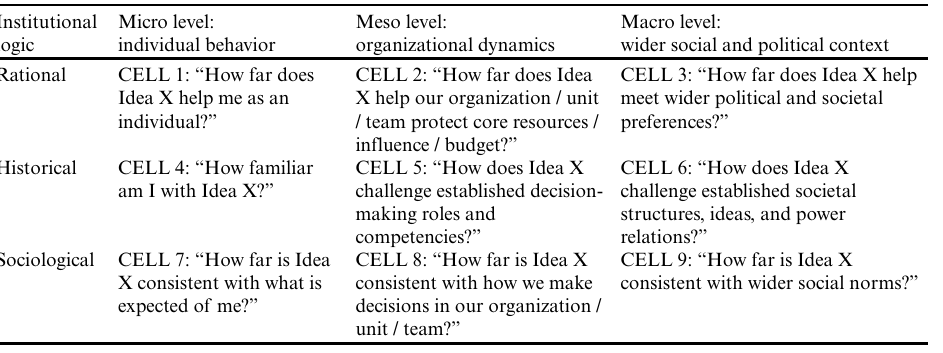
Table 1 . What might we hear when a new idea comes up against existing